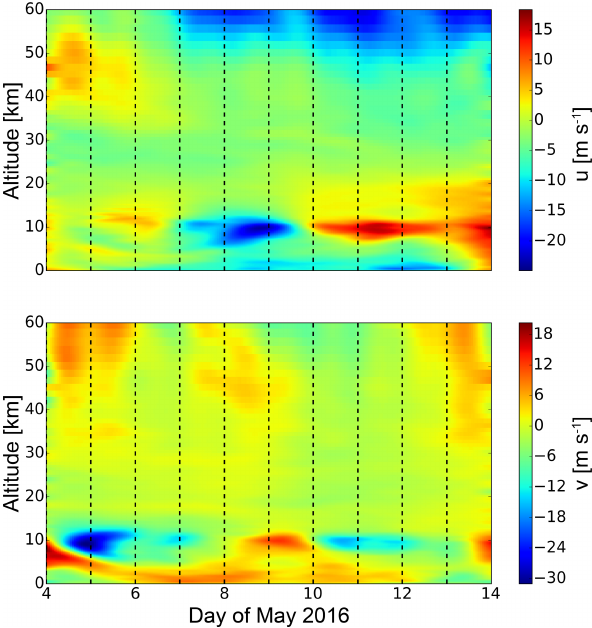
Figure 8. Zonal and meridional wind above Kühlungsborn on 4– 13 May 2016 derived from ECMWF. The data have been low-pass- filtered with a cutoff period of